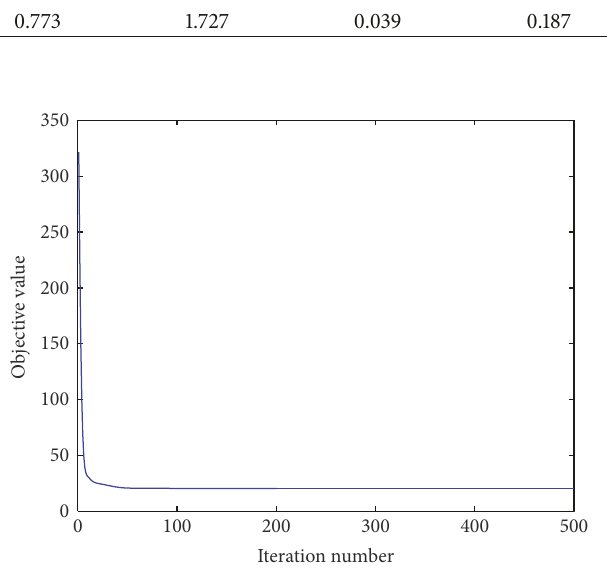
Figure 1: Iteration number versus objective value for GSNMF when 𝜆 = 1 .